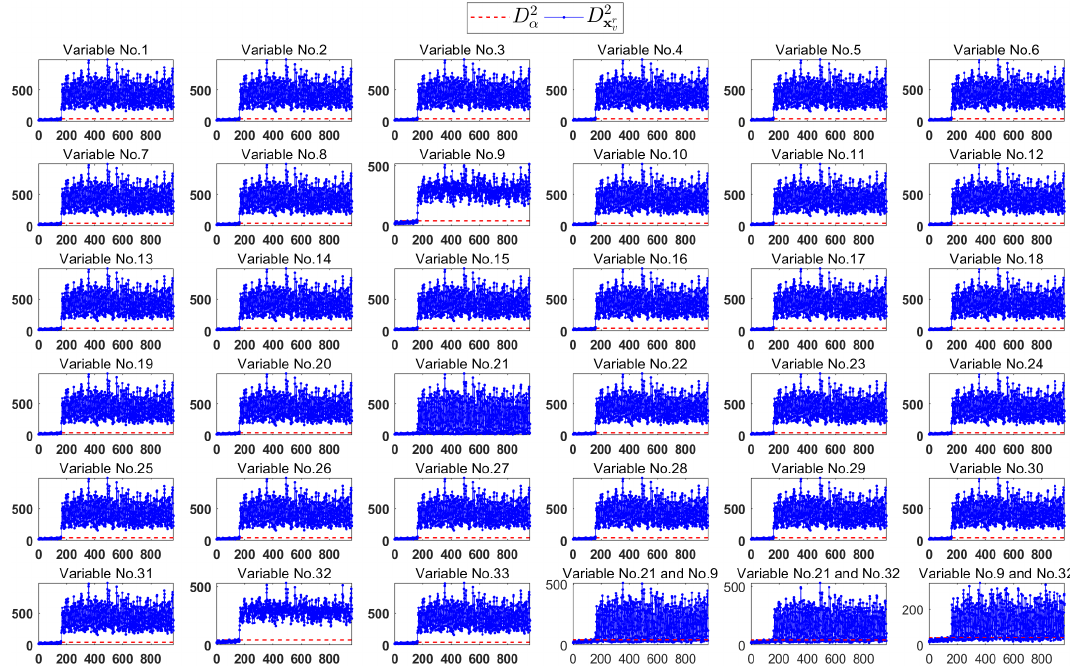
Figure 22. The fault detection results of reconstructed samples by estimating and replacing each variable for fault 14 of